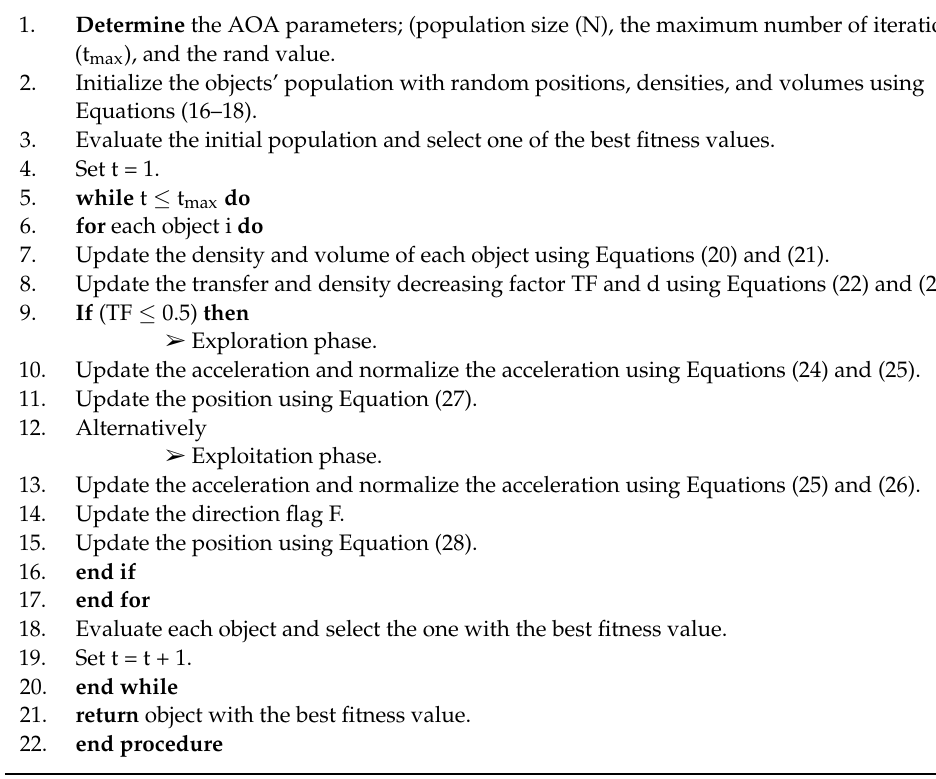
Algorithm 1: Pseudo code of the